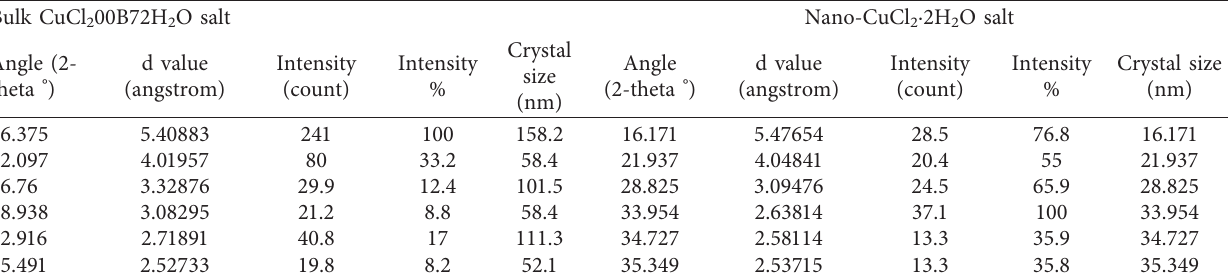
· 2H 2 2 O salt. 2 .2H 2 O